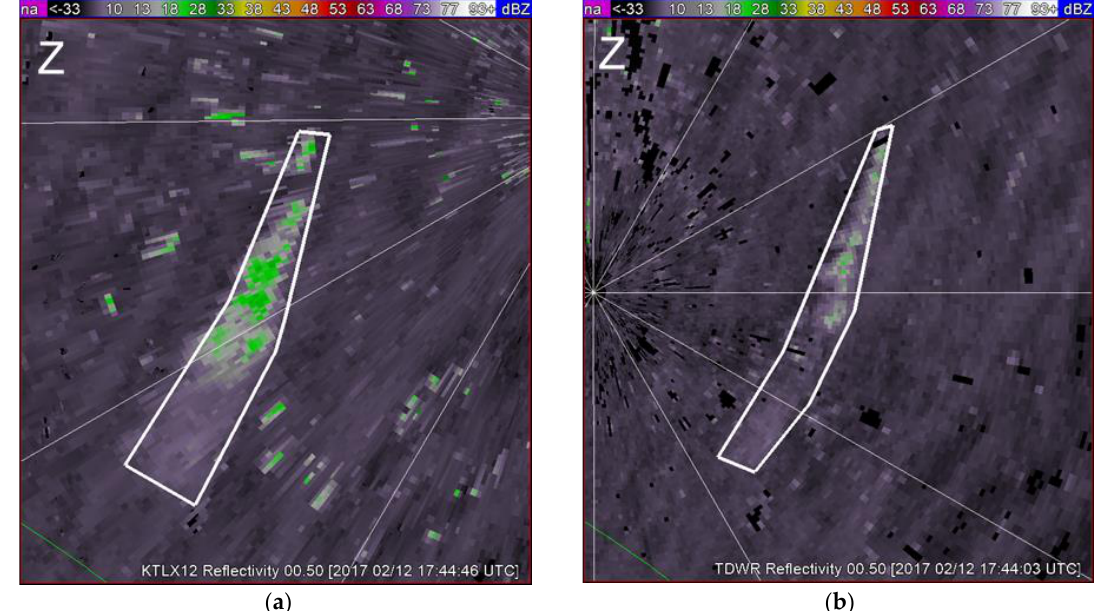
Figure 4. Observed reflectivity fields: ( a ), with the Oklahoma City WSR-88D ( λ = 10 cm, code name KTLX), and ( b ), Terminal Doppler Weather Radar (TDWR) ( λ = 5.35 cm, code name TOKC) located in Norman for surveillance of the Will Rogers Airport. The color bar indicates reflectivity in dBZ. Date is February 12, 2017 and the polygons encompass the plumes.